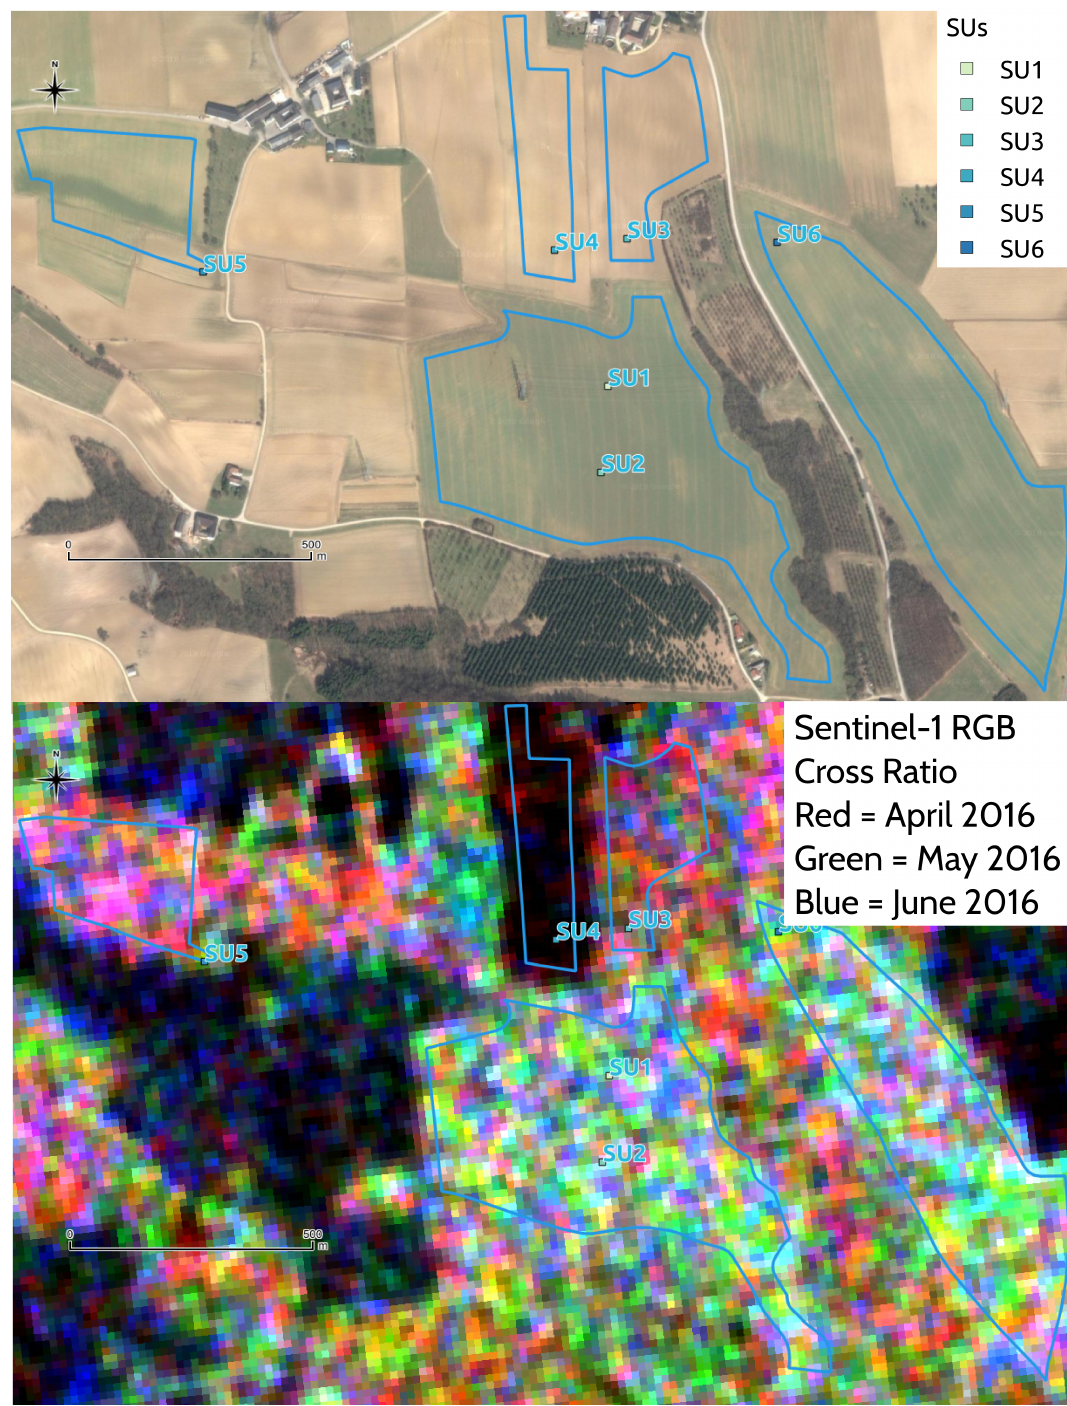
Figure 1. Map of the HOAL indicating the Sampling Unit locations (blue squares) and the area per field used to calculate Sentinel-1 indices (blue polygons). The top graph shows a Google Earth Image as the background, the lower figure depicts monthly averaged Sentinel-1 CR for the months April (Red), May (Green) and June (Blue)